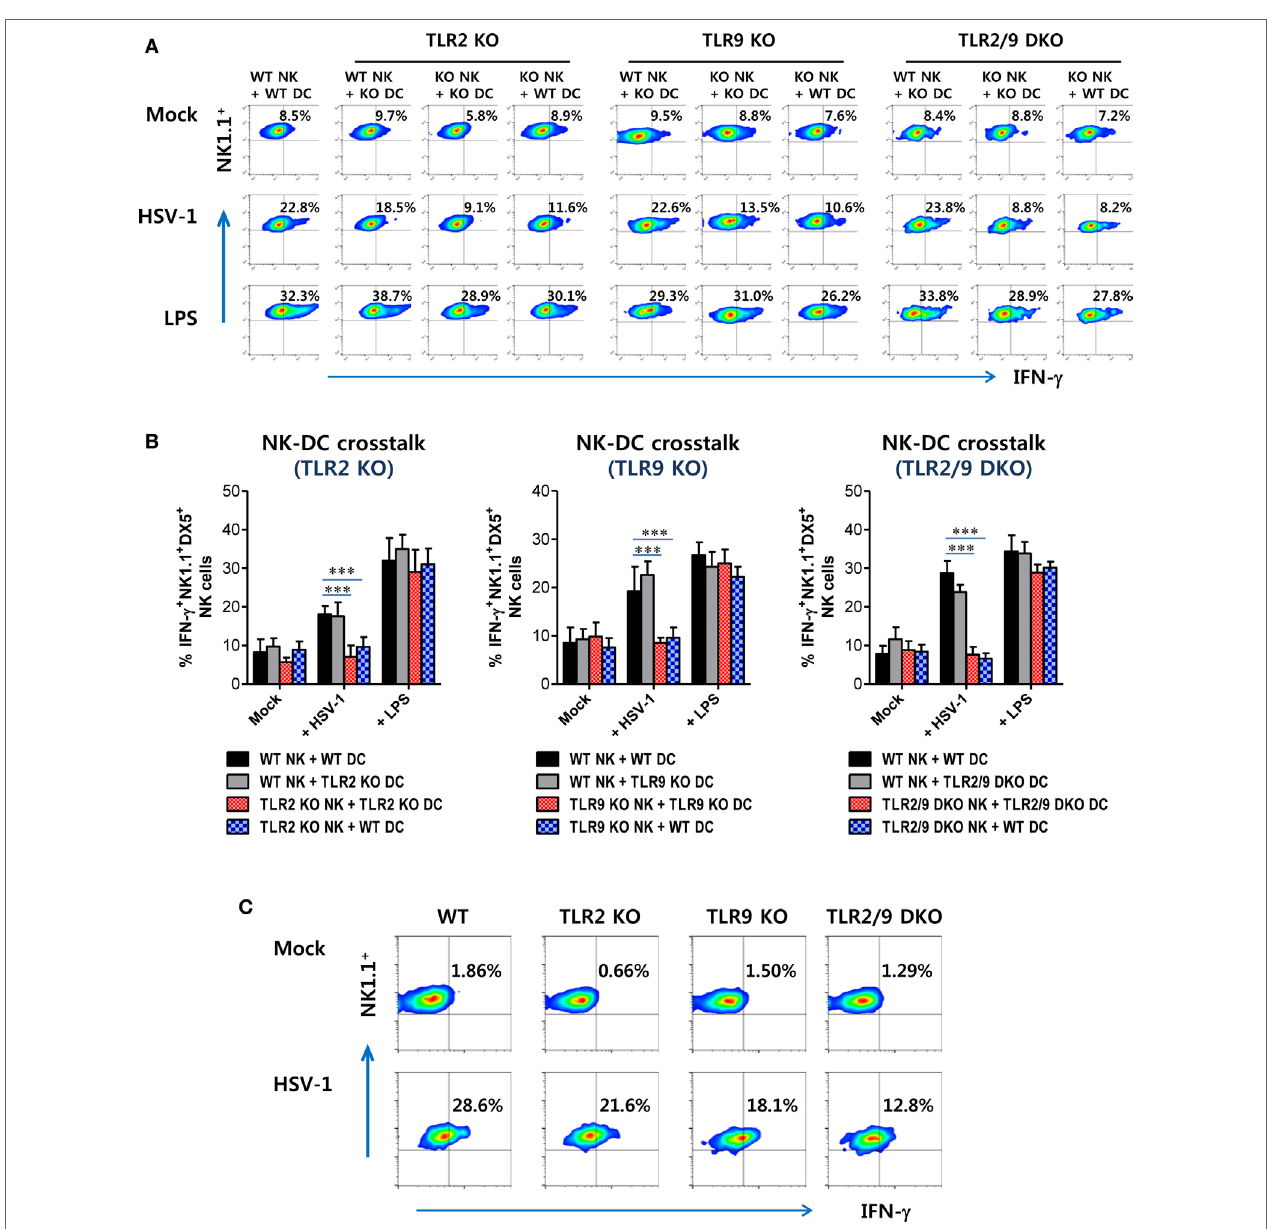
FigUre 9 | Both TLR2 and TLR9 signaling on NK cells, but not dendritic cells (DCs), are required for NK cell activation upon herpes simplex virus (HSV)-1 infection. Sorted CD3 - NK1.1 + DX5 + NK cells from the spleen (Spl) of wild-type (WT), TLR2 KO, TLR9 KO, and TLR2/9 double knock-out (TLR2/9 DKO) mice were co-cultured with CD11c + DCs derived from bone marrow cells of WT, TLR2 KO, TLR9 KO, or TLR2/9 DKO mice and stimulated with HSV-1, lipopolysaccharide (LPS), or left uninfected (Mock). The activity of NK cells was assayed by intracellular IFN- γ staining 48 h after infection. (a) The plots that show the percentage of IFN- γ -positive cells among CD3 - NK1.1 + DX5 + NK cells. (B) The mean percentage ± SEM of IFN- γ -positive cells among CD3 - NK1.1 + DX5 + NK cells. (c) Direct activation of NK cells by dual TLR2/9 recognition. Sorted NK cells from the Spl of WT, TLR2 KO, TLR9 KO, and TLR2/9 DKO mice were infected with HSV-1 (5.0 moi) and assayed for intracellular IFN- γ 24 h later. The values in the plots represent the average percentage of IFN- γ -producing cells in NK1.1 + cells after gating on CD3 - NK1.1 + DX5 + NK cells. One-way ANOVA with repeated measurements and Bonferroni post hoc tests were performed in (B) . Data shown are representative of three independent experiments ( n = 4–5). *** p < 0.001 comparing levels between the indicated